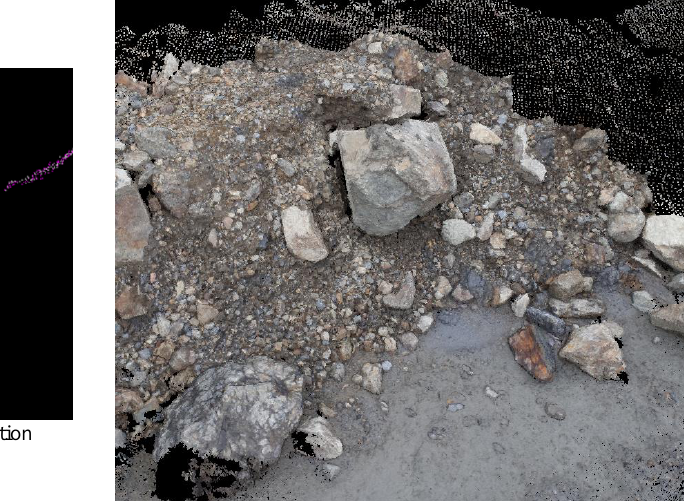
Figure 5. The effect of CCICP